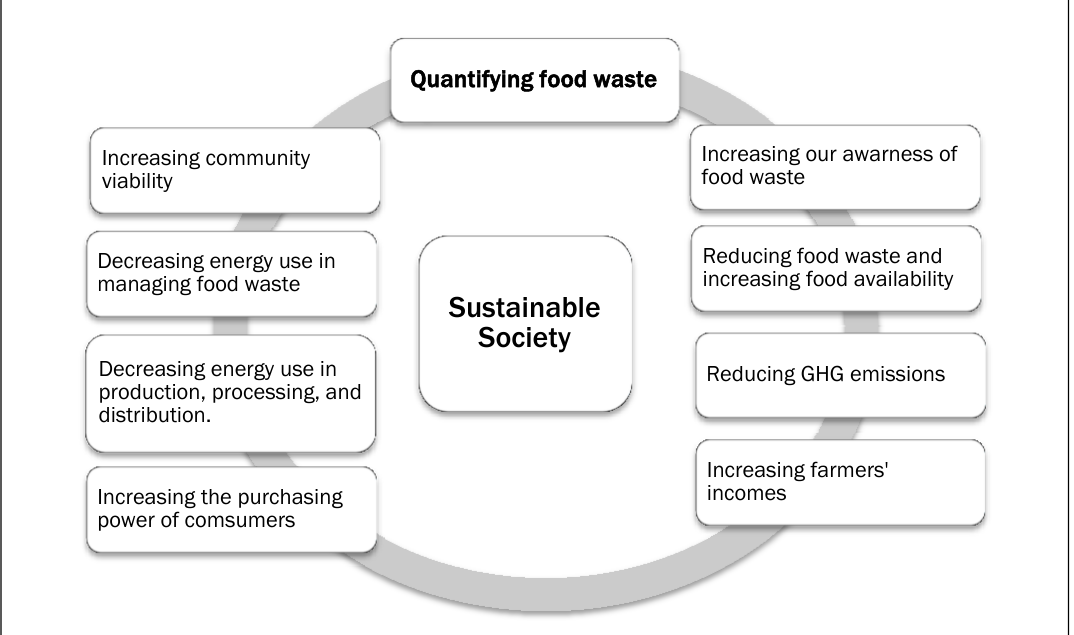
Figure 1. A Holistic Understanding of the Benefits of Quantifying Food Waste and Creation of a More Sustainable